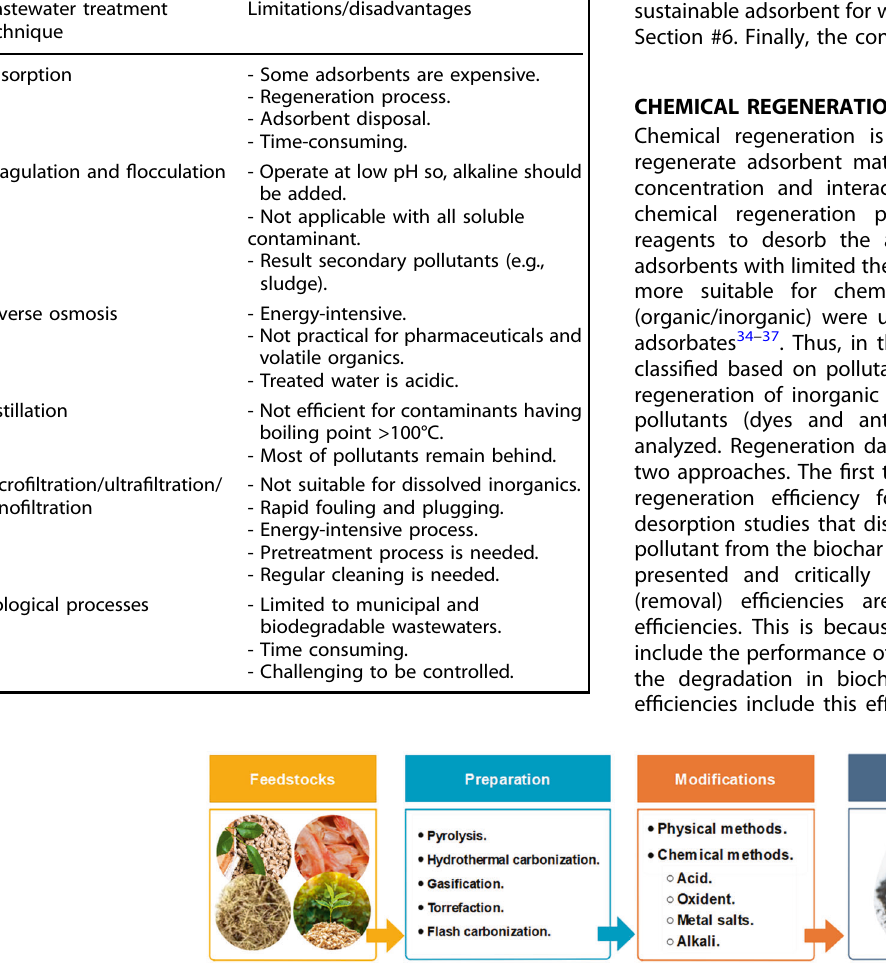
Fig. 1 Feedstock, preparation, and modi fi cation techniques of biochar. The three main steps should be followed to synthesize activated